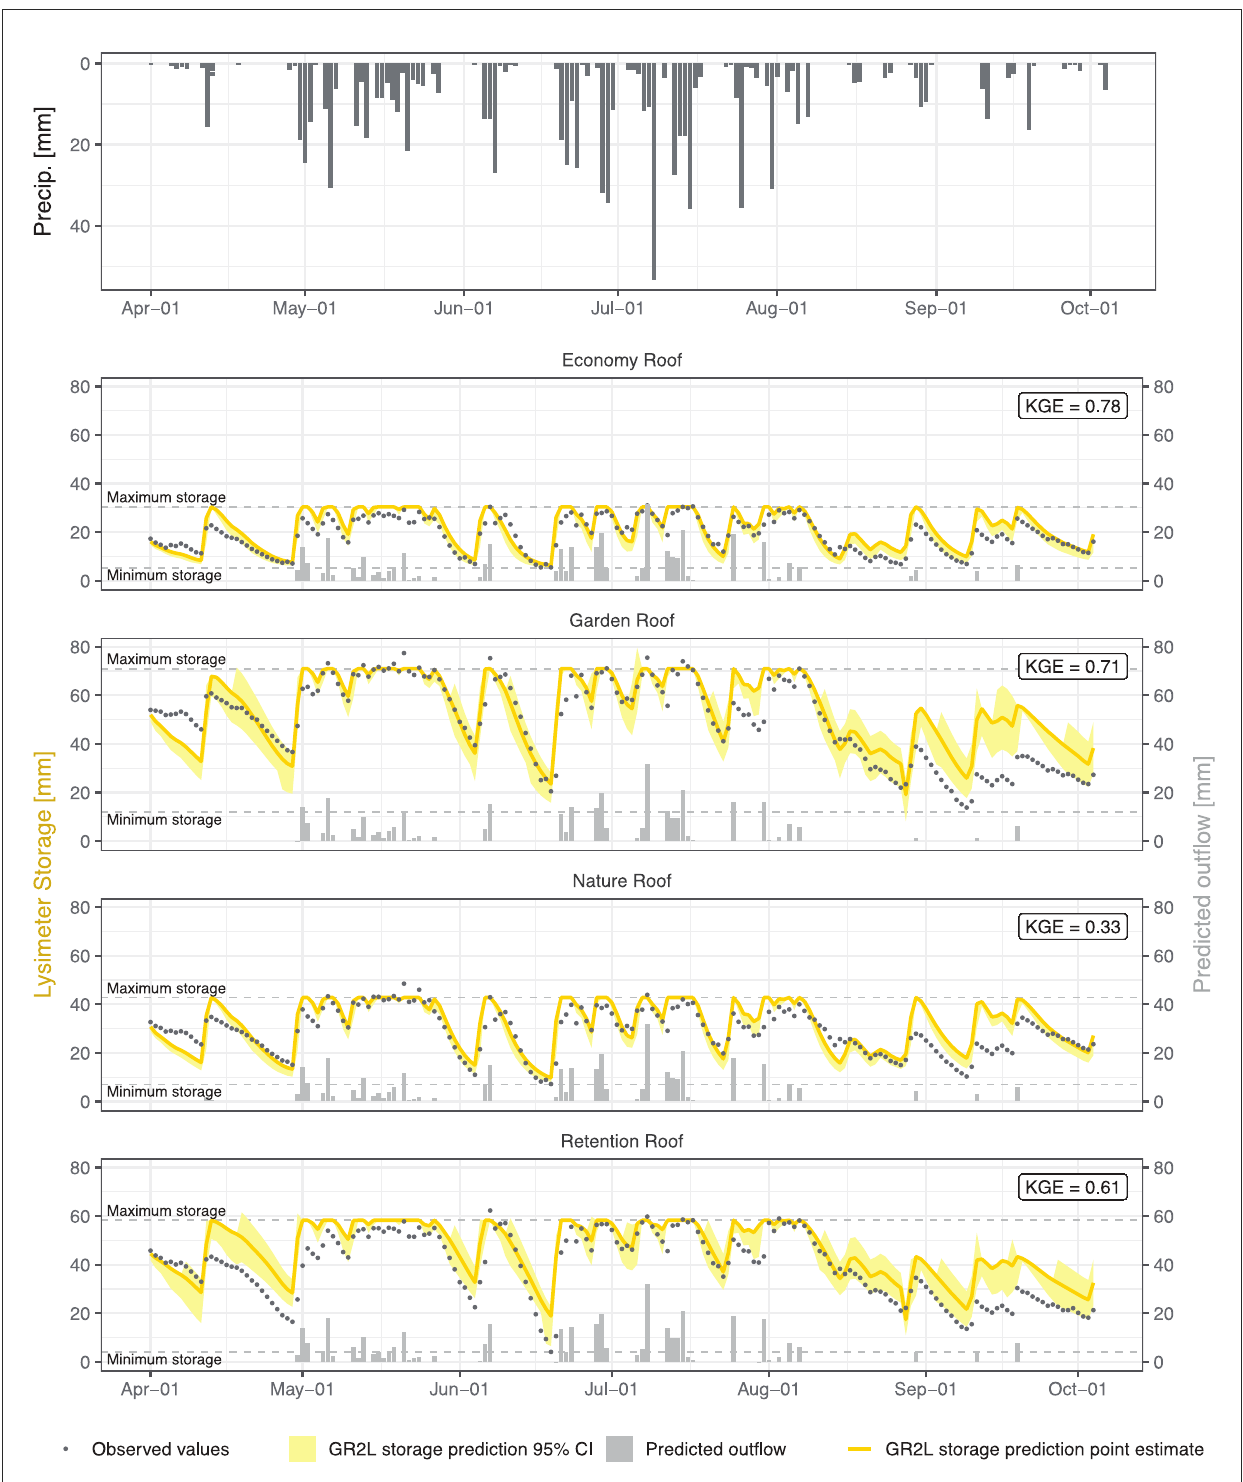
FIGURE3 Results of the GR2L simulation using optimized parameters. GR2L results are presented as point estimates with 95% confidence interval (yellow lines with shaded area) for the total storage time series and point estimates (gray columns) for predicted outflow from the four green roof types, respectively. Observed storage over time as derived from lysimeter data is indicated as black points. Dashed lines represent the model limits for minimum and maximum total storage within each green roof type. Corresponding simulation Kling-Gupta efficiency (KGE) values are given in the boxes in the upper right corner of each